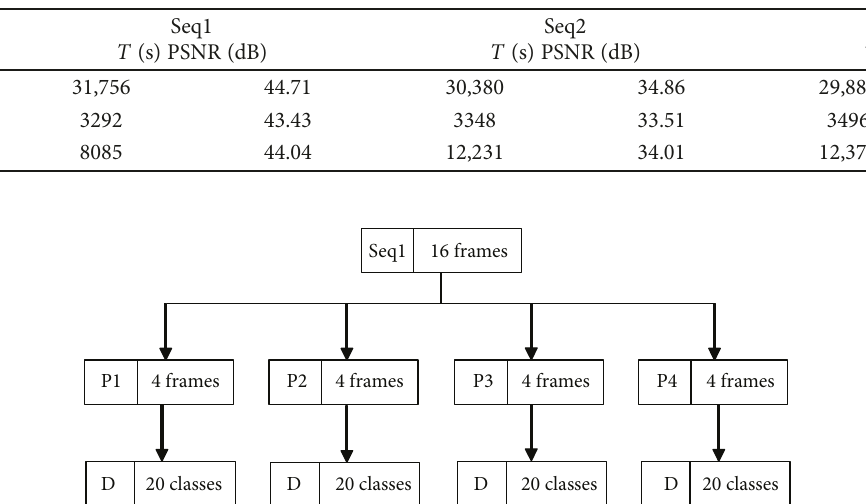
Table 5: Comparison of performance of di ff erent strategies for the traditional algorithm and proposed algorithm.